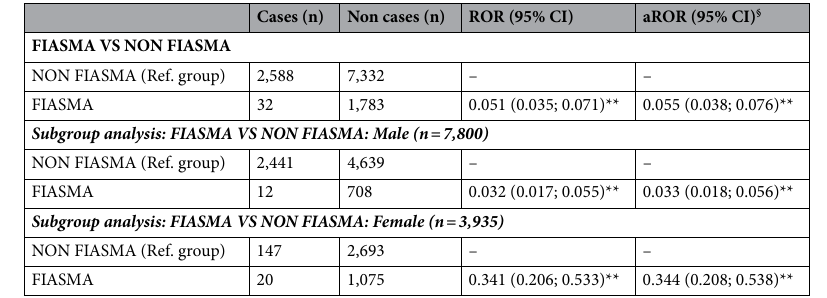
Table 4. Logistic regression analyses showing the reporting risk of weight gain after FIASMA based therapy compared to NON FIASMA (reference group), also according to gender (subgroup analysis). **P < 0.001. § Adjustment for age, concomitant drugs related with the risk of weight gain.